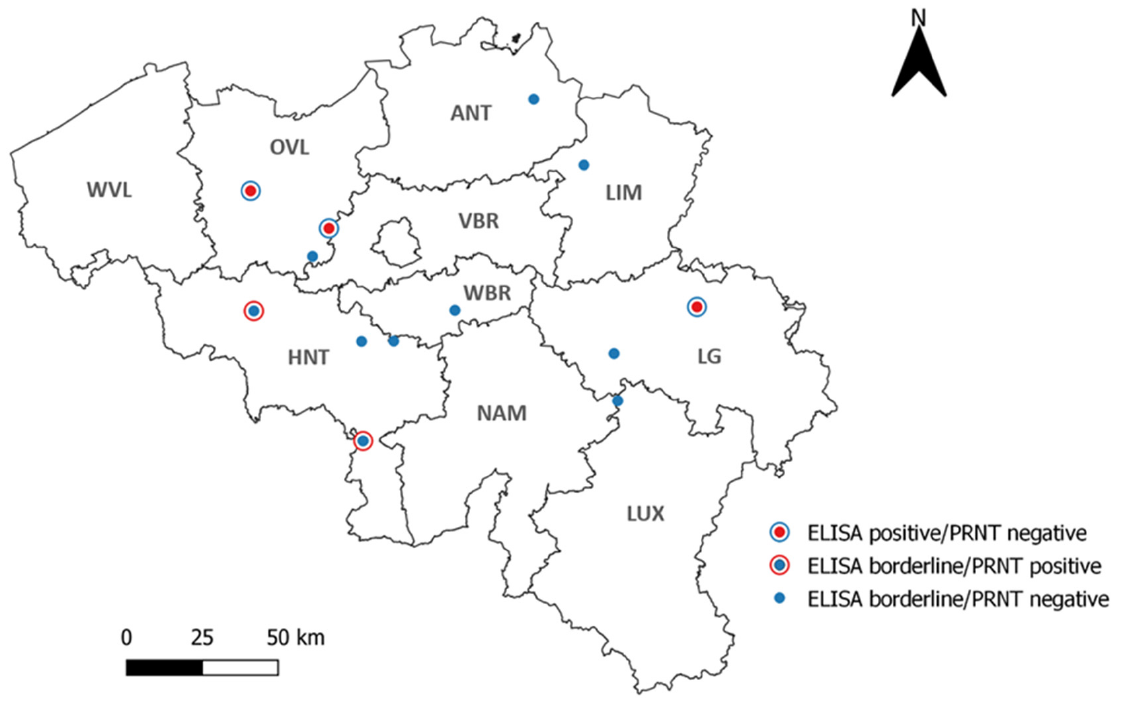
Figure 3. Geographical repartition of the 13 (out of 480) TBEV-positive and borderline sheep serum samples according to ELISA. WVL: West Flanders, OVL: East Flanders, ANT: Antwerp, LIM: Lim- burg, VBR: Flemish Brabant, WBR: Walloon Brabant, HNT: Hainaut, NAM: Namur, LG: Liege, LUX: Luxembourg.